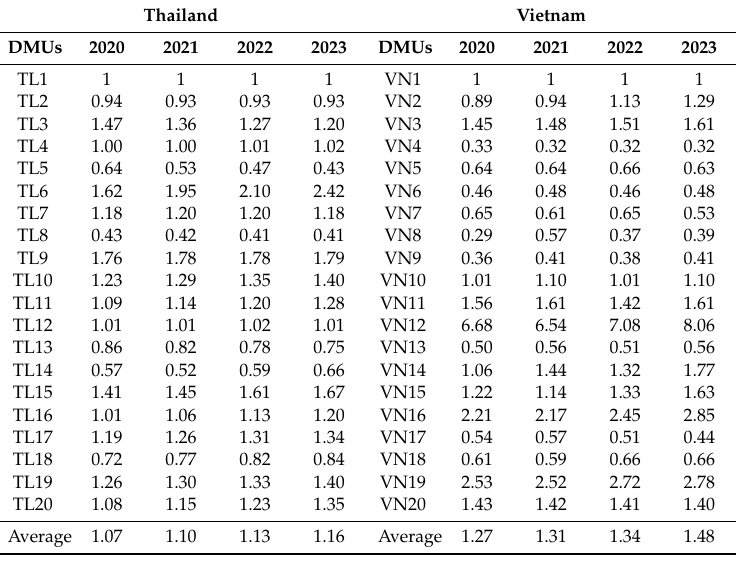
Table 8. Efficiency score over the period of 2020 to 2023. Thailand Vietnam Table 8. E ffi ciency score over the period of 2020 to DMUs